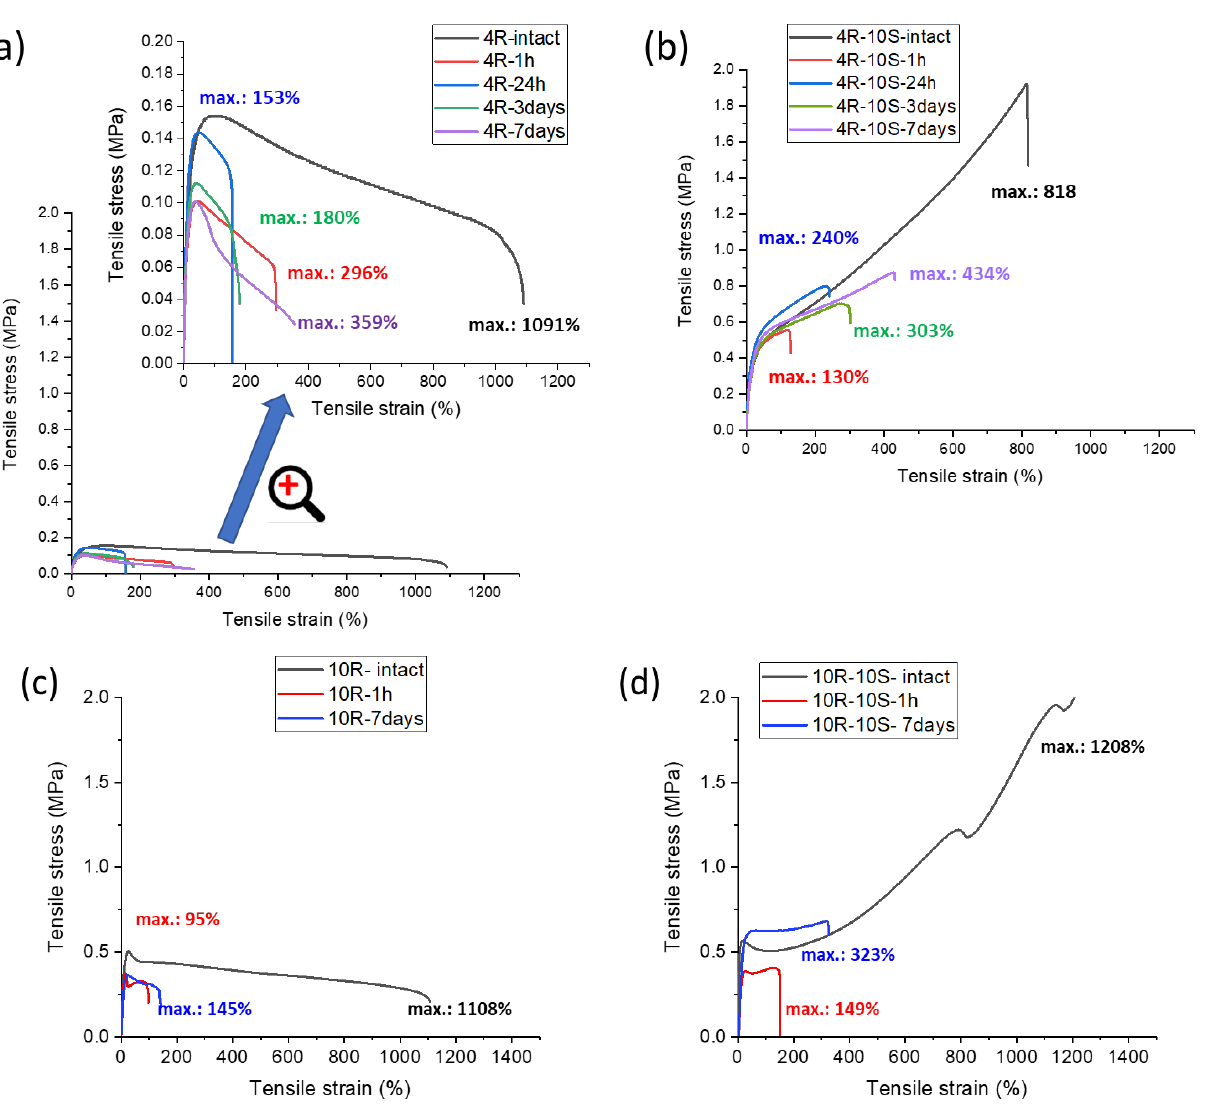
Figure 11. Self-healing of nanocomposite elastomers based on poly(MEA): ( a , b ): crosslinked by 4 wt.% of clay: ( a ) SMA-free and ( b ) SMA-doped (10 mol%); ( c , d ): crosslinked by 10 wt.% of clay: ( c ) SMA-free and ( d ) SMA-doped (10 mol%) system. Healing time is given in legend description.